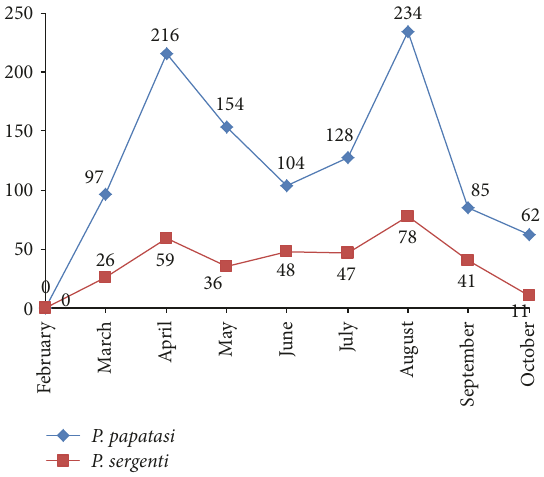
Figure 3: Sand flies seasonal activity in Yazd and its outskirts, 2015.